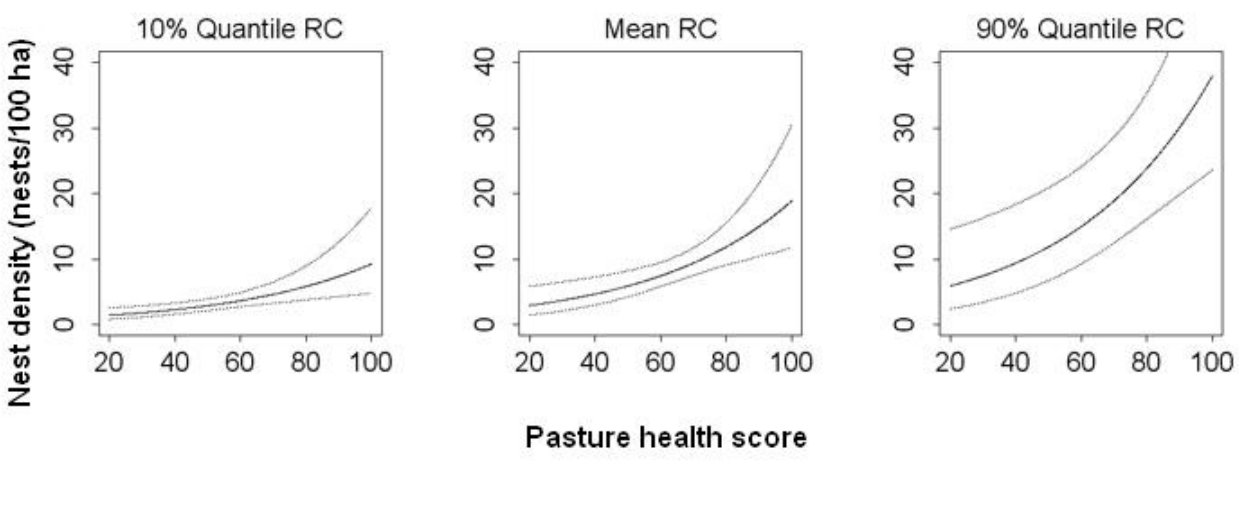
Fig. 2 . Predicted nest density and 95% CIs (dotted lines) in the Aspen Parkland of Alberta, Canada, in relation to field residual cover (RC) and pasture health score, averaged over both study years and based on the nest density model DEN (proportion of flooded basins + residual cover + pasture score; n = 100 fields). Mean proportion of flooded wetland basins within a study site (PBASIN = 0.2547) was used in the model. The co-variates RC and pasture health score are correlated across all values (Pearson’s product-moment correlation, r = 0.459, P < 0.01), but the correlation is nonsignificant at pasture health score values > 57 ( r = 0.190, P =